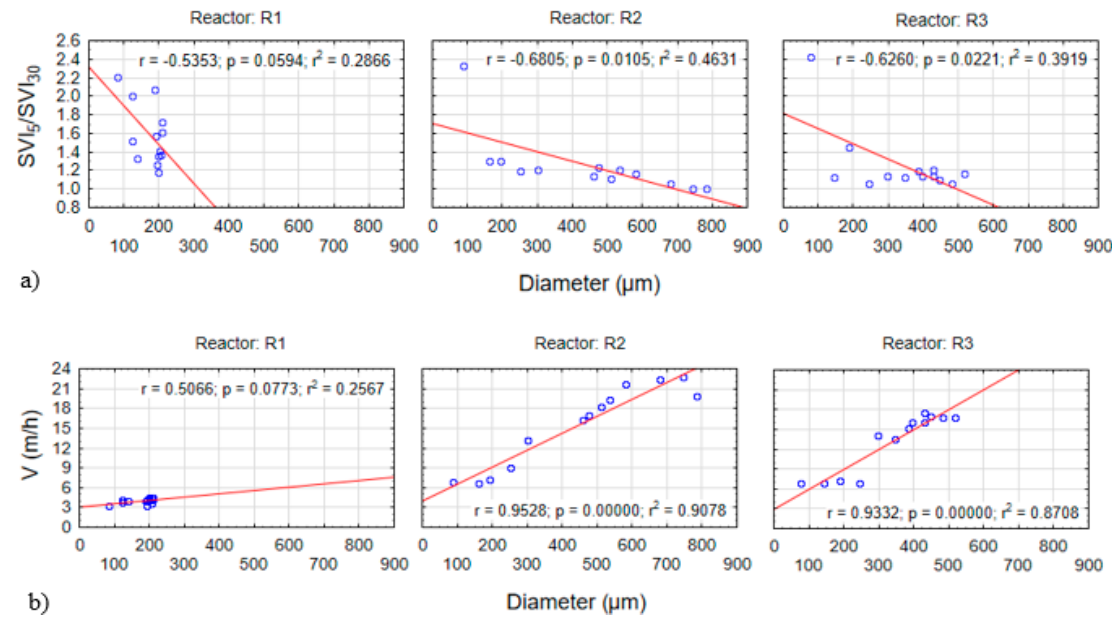
Figure 3. Scatter graphs showing the relationships between the granule diameter and SVI 5 /SVI 30 ( a ) and settling velocity ( b ).